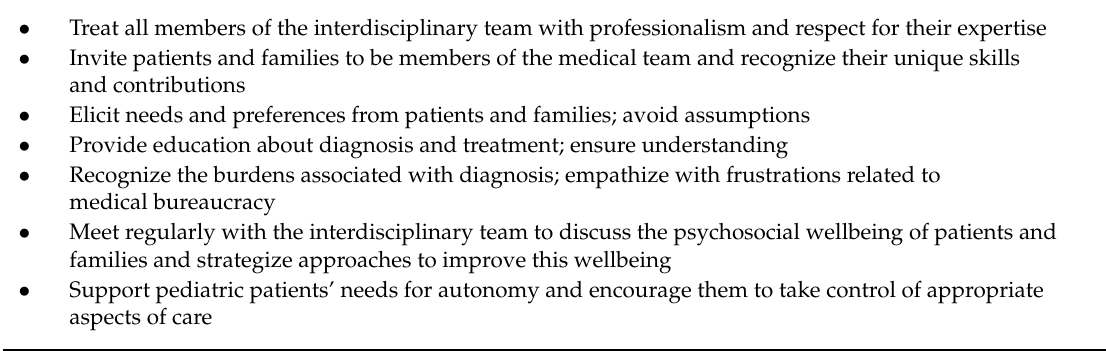
Table 4. Guidelines for developing therapeutic alliance with patients and families.